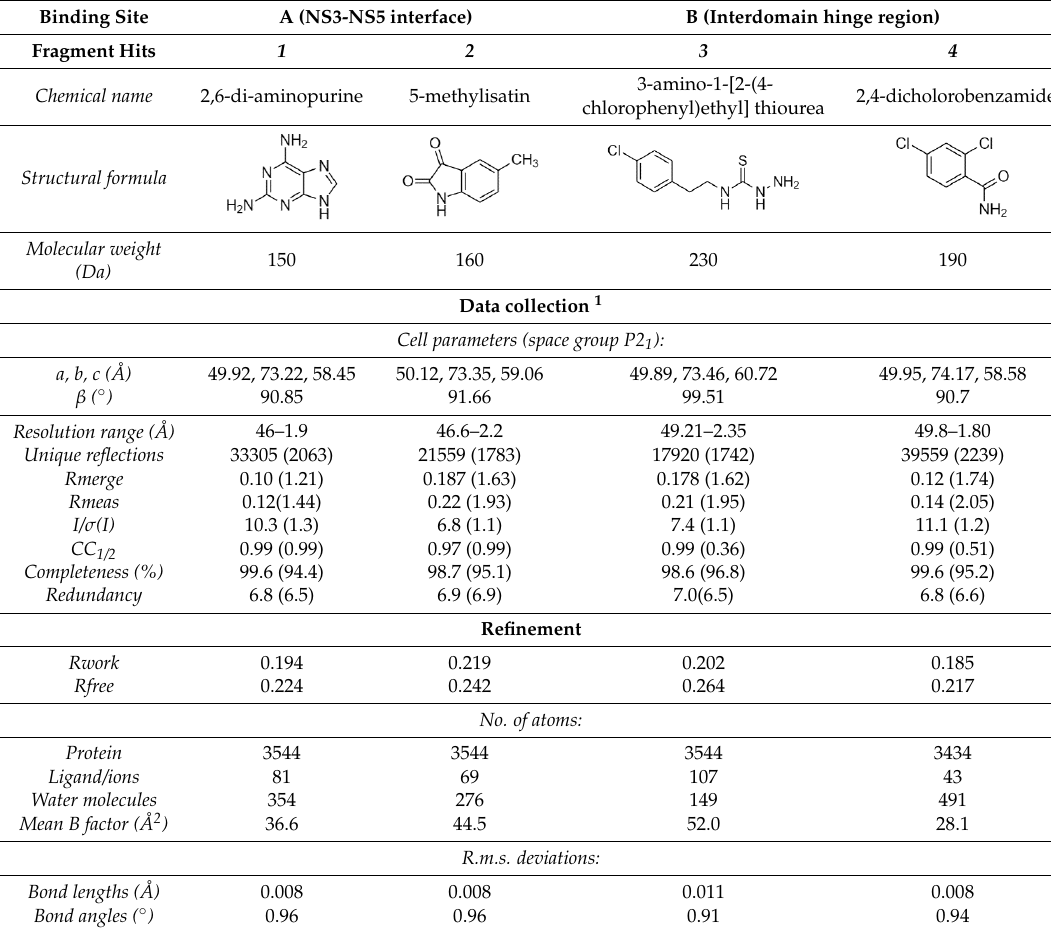
Table 2. Crystallographic data collection and refinement statistics.